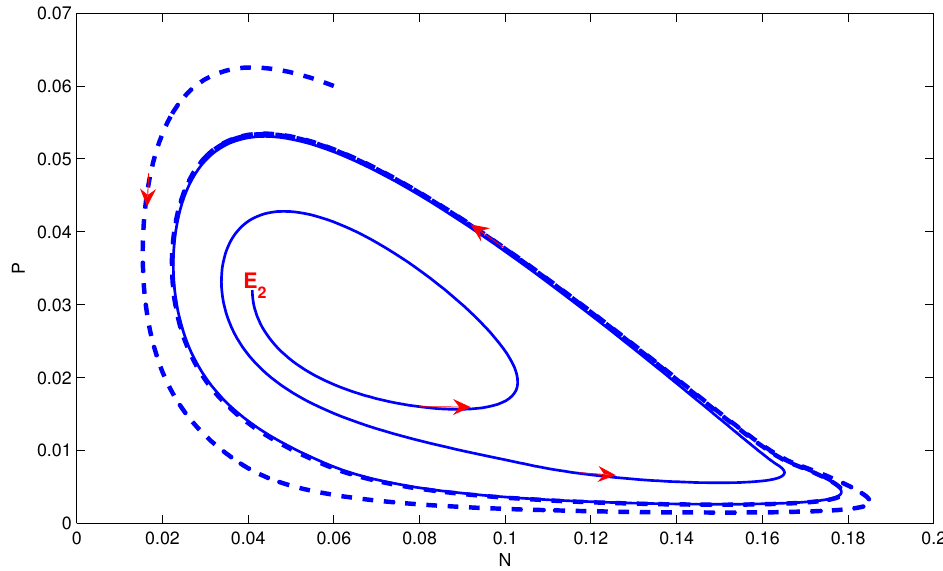
Figure 9. A stable limit cycle of model Equation (3) encircling the unstable equilibrium E 1